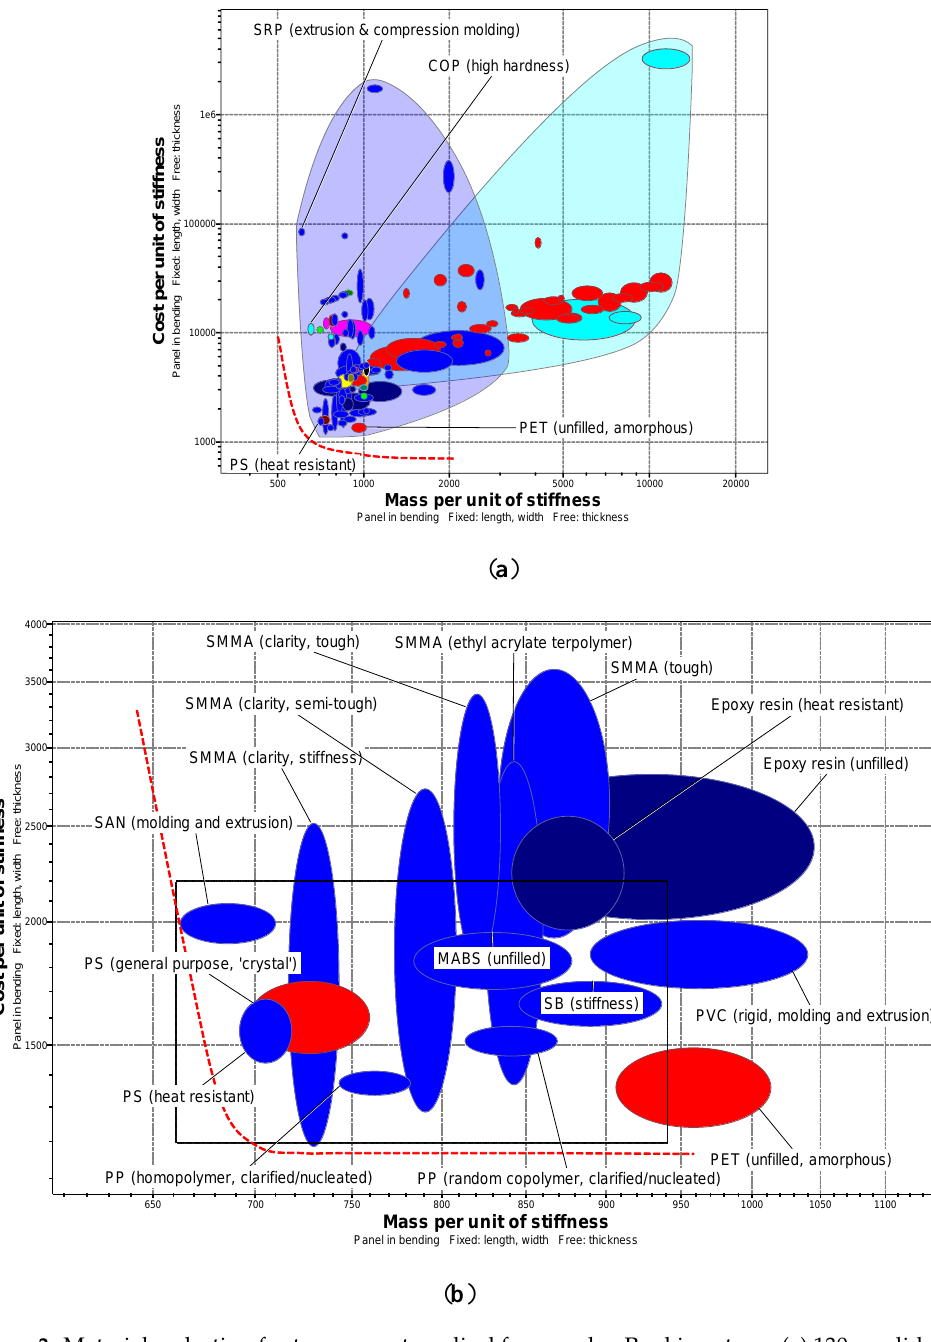
Figure 3. Materials selection for transparent medical face masks. Ranking stage: ( a ) 130 candidates; ( b ) 16 candidates (red—optical quality; blue—transparent). (Charts and data from CES EduPack 2019, Granta Design Limited, Cambridge, UK, 2019